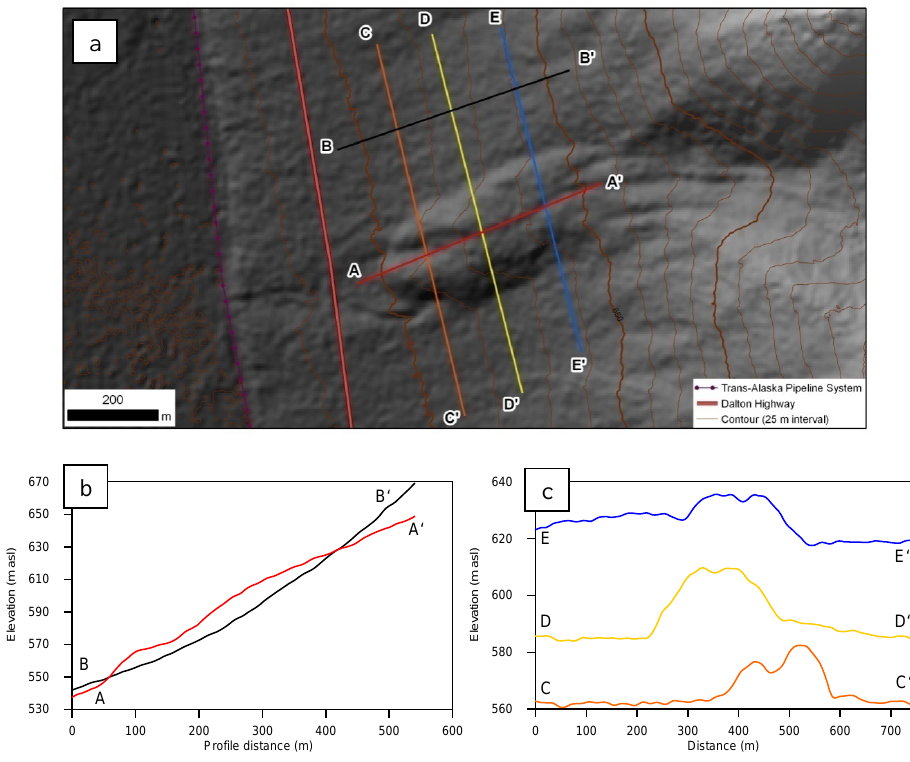
Figure 3. Surface morphometry of frozen debris-lobe A (FDL-A).a) Location of cross sections 3 Fig. 3. Surface morphometry of frozen debris-lobe A (FDL-A). (a) Location of cross sections and long profiles; (b) long profiles, over FDL-A (A–A 0 ), and next to FDL-A (B–B 0 ); (c) three cross sections over FDL-A (C–C 0 , D–D 0 , and E–E 0 and long profiles; b) long profiles, over FDL-A (A-A’), and next to FDL-A (B-B’); c) three cross 4 sectionsover FDL-A (C-C’, D-D’, and E-E’). 5